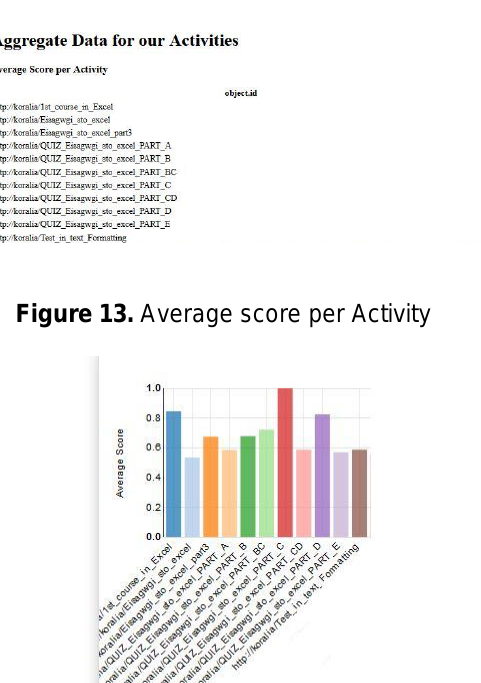
Figure 17. Aggregate Data for students